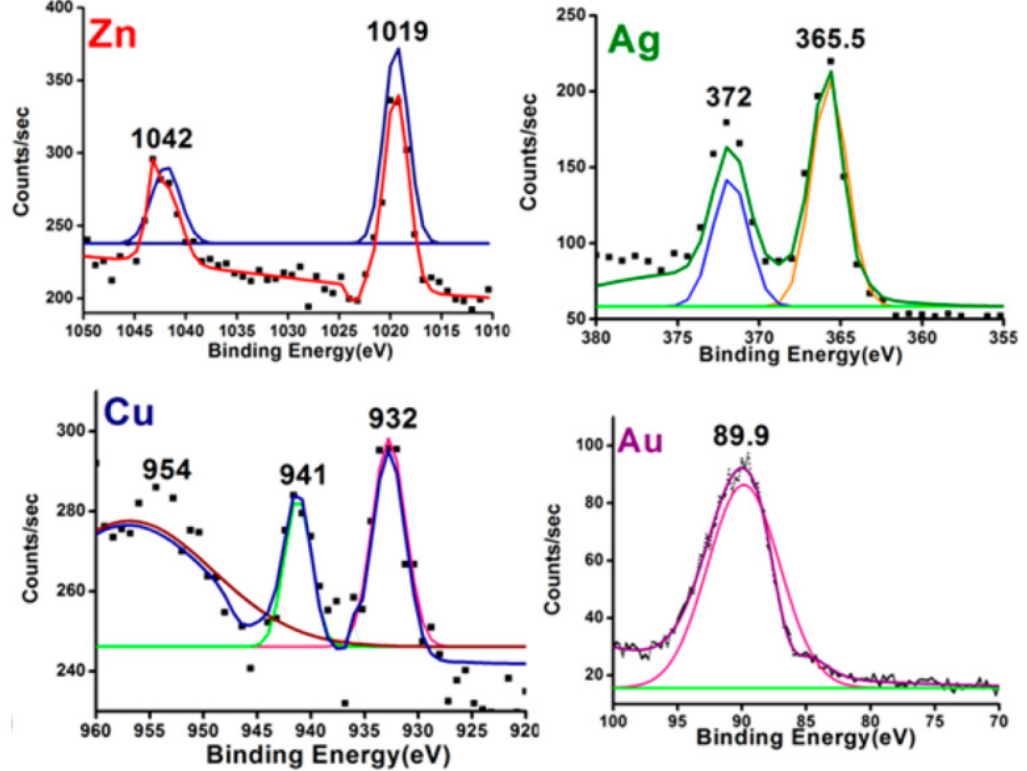
Figure 5. HR-XPS spectra of prepared ZnO nanocomposite materials. Red = zinc; green = silver; blue = copper; pink = gold; black squares = data points